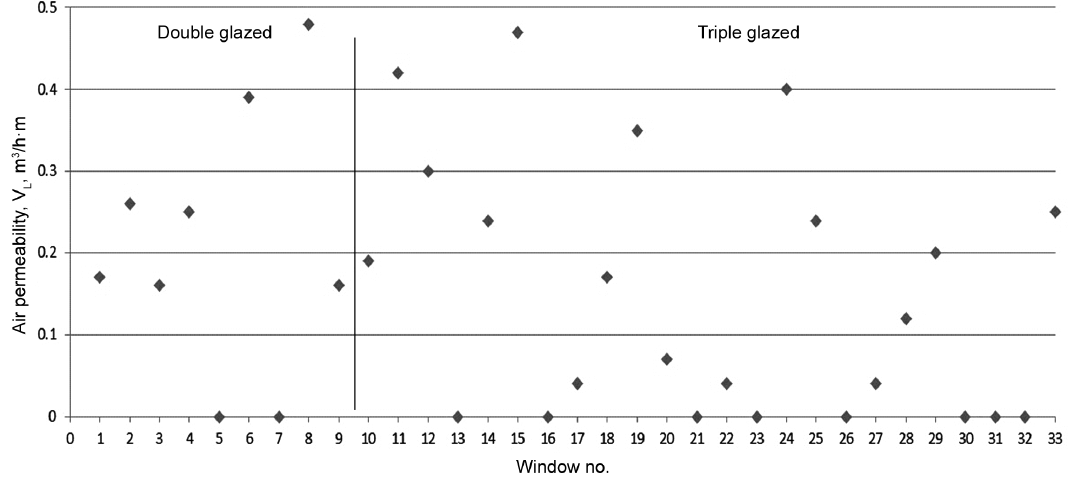
Figure 6. Air permeability to the length of opening joins (VL) at 600 Pa